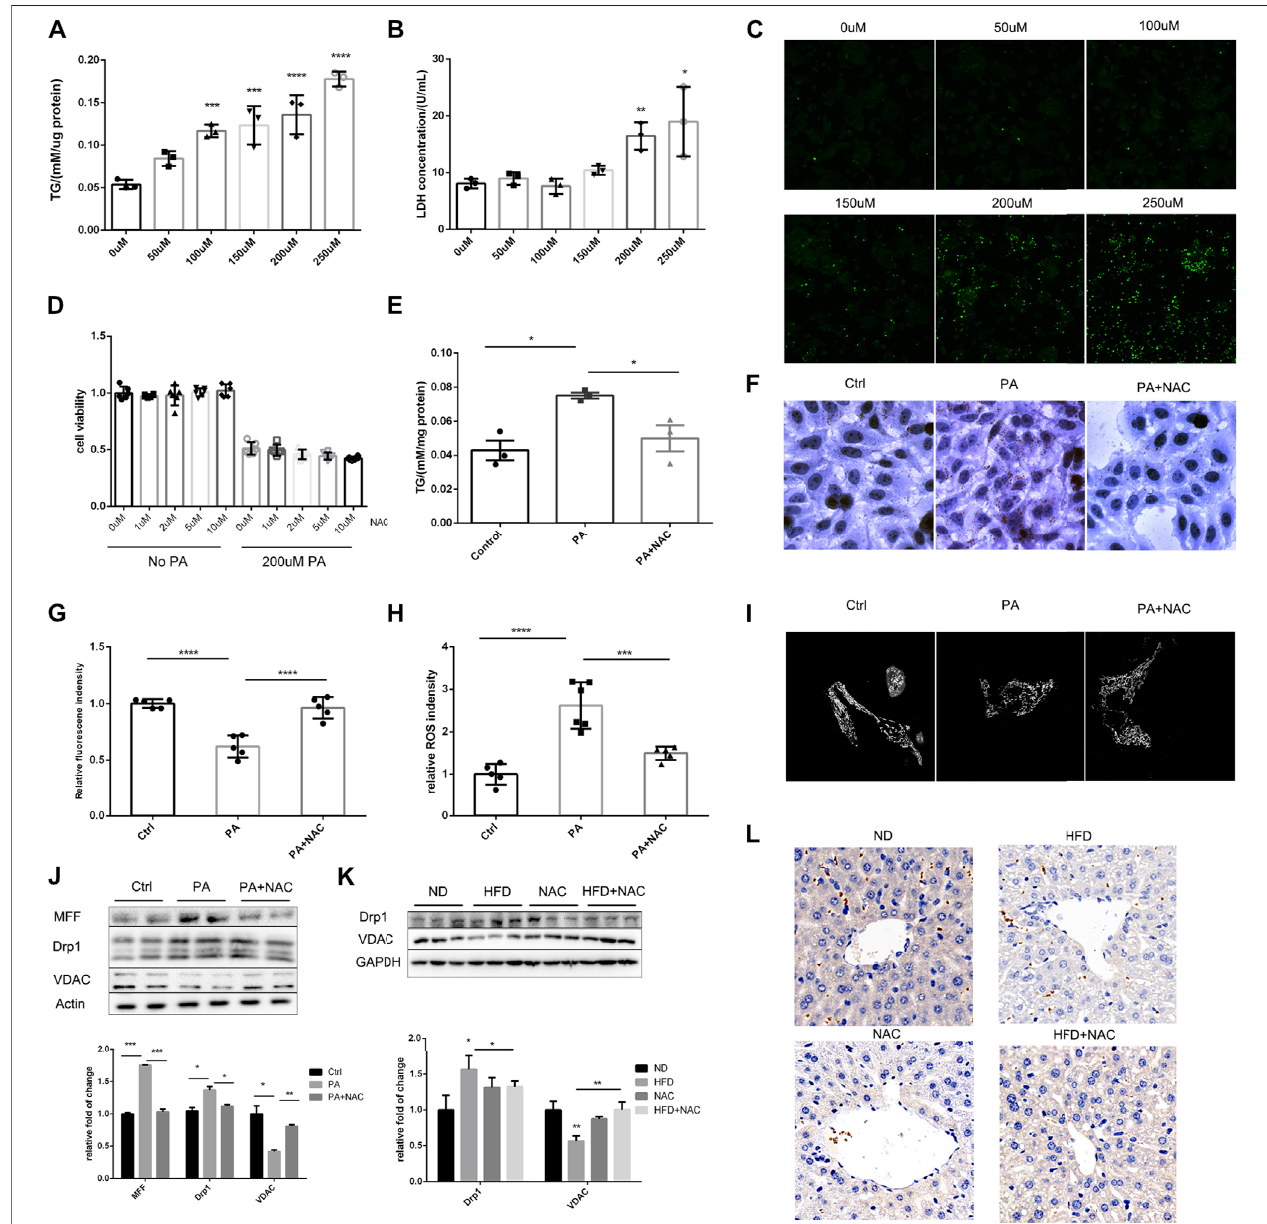
FIGURE 2 | NAC treatment could reduce intracellular TG accumulation via preserving mitochondrial function. (A) Intracellular TG content was measured with TG measurement kit,and theconcentrationwasadjusted toprotein level; (B) LDHreleasement incellculture medium under differentPAconcentration stimulation; (C) DHE staining showed intracellular ROS level under different PA concentration; (D) cell viability of different concentration of NAC treatment under control and 200 μ M PA stimulation; (E) intracellular TG concentration after PA stimulation and NAC treatment; (F) oil red staining of LO2 cell stimulated with PA or together with NAC treatment; (G) mitochondrial membrane potential of LO2 cells measured by TMRE fl uorescence intensity in each group; (H) intracellular ROS level measured by DHE fl uorescence intensity in each group; (I) LO2 cells were stained by MitoTracker and its mitochondrial morphology was observed by confocal microscopy. More fragmented mitochondria were observed in the PA group; (J,K) representative Western blot image of mitochondria fi ssion-related proteins after different treatment in LO2 cells (J) or in mice hepatic tissue (K) ; the experiment was conducted triple; (L) immunohistochemistry analysis of mice hepatic VDAC protein level (* p < 0.05, ** p < 0.01, *** p < 0.001, and **** p < 0.0001; all the data signi fi cance was analyzed by ANOVA).